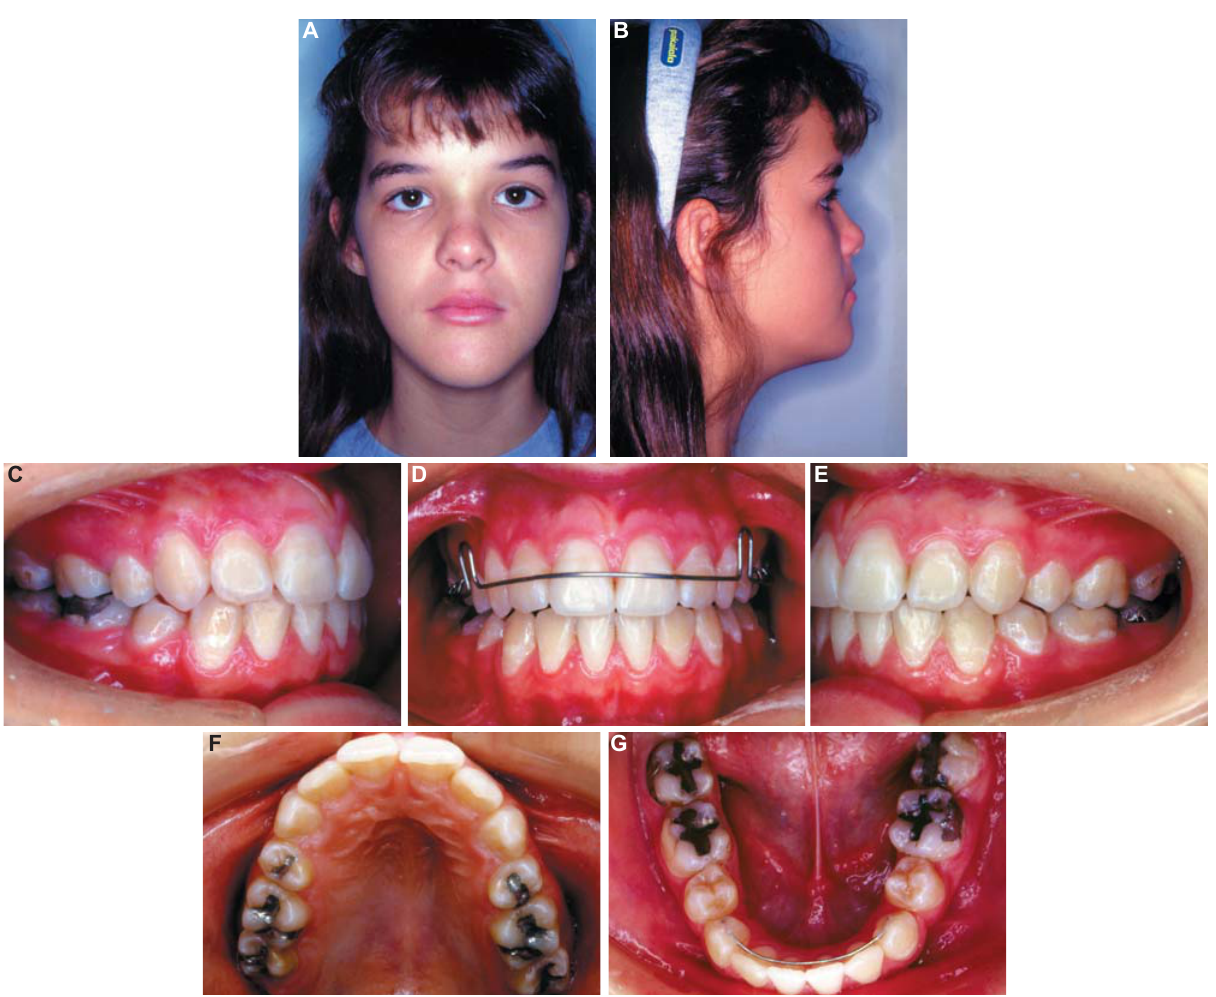
Figure 7- End of comprehensive phase: extraoral (A and B) and intraoral (C-G) photographs (the parents authorized the publication of these